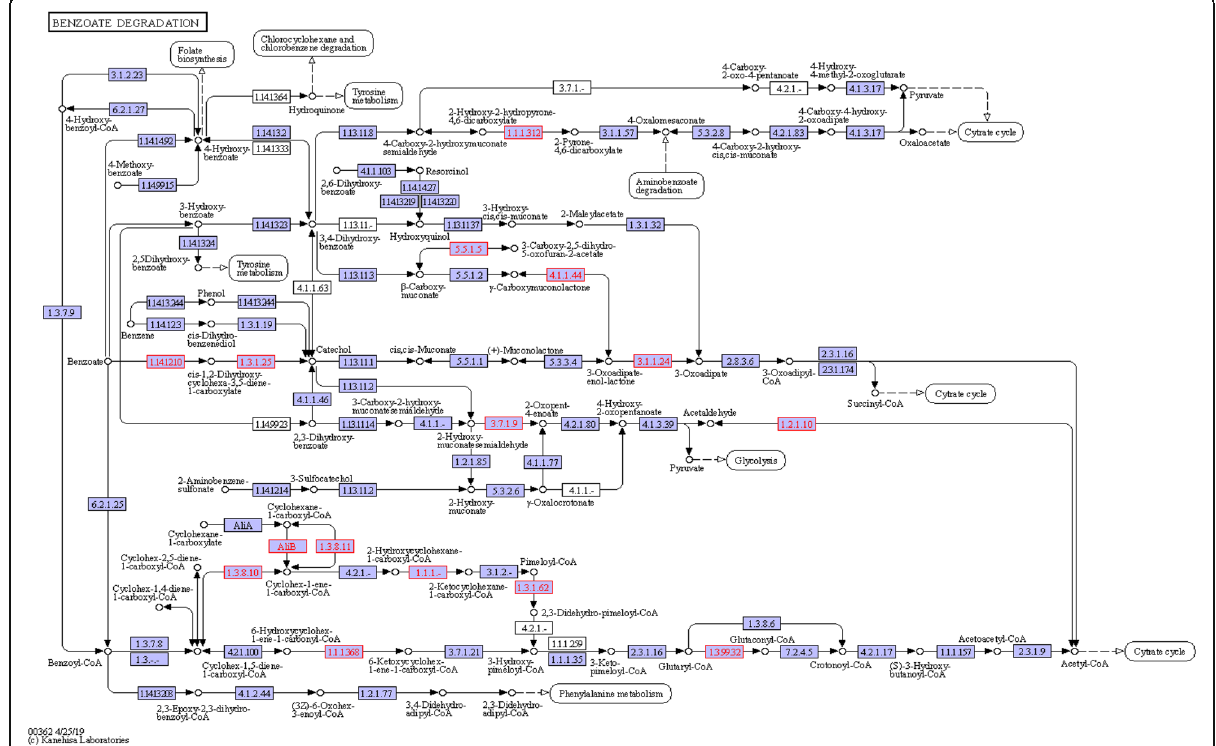
Fig. 4 The benzoate degradation pathway performed using the KEGG pathway in KEGG Orthology. EC numbers in red are the benzoate degradation genes identified in the FN1 microcosm. The identified genes include pcaD ; 3-oxoadipate enol-lactonase [EC:3.1.1.24], mhpF; acetaldehyde dehydrogenase [EC:1.2.1.10], aliB ; cyclohexanecarboxyl-CoA dehydrogenase [EC:1.3.99.-], pimeloyl-CoA dehydrogenase [EC:1.3.1.62], benD-xylL ; dihydroxycyclohexadiene carboxylate dehydrogenase [EC:1.3.1.25 1.3.1.-], benC-xylZ ; benzoate/toluate 1,2-dioxygenase reductase component [EC:1.18.1.-], badH ; 2-hydroxycyclohexanecarboxyl-CoA dehydrogenase [EC:1.1.1.-], had ; 6-hydroxycyclohex-1-ene-1-carbonyl-CoA